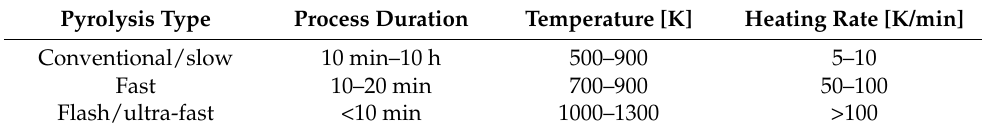
Table 1. Typical technological parameters of different types of pyrolysis